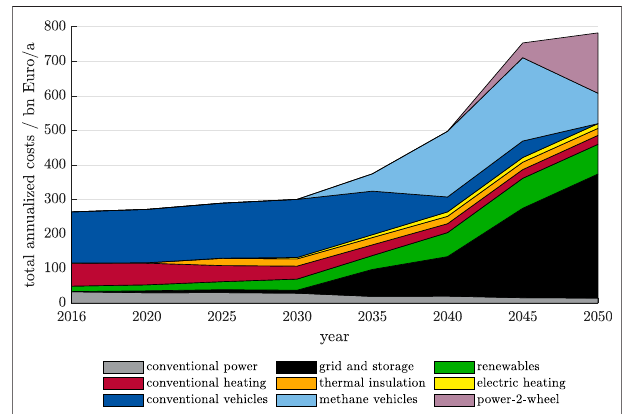
FIGURE 2 | Total annualized costs for the energy-transition path reaching the 85% reduction target. Technologies are lumped for clarity of presentation. Power-2-wheel includes battery electric vehicles, fuel cell vehicles, and synthetic diesel.